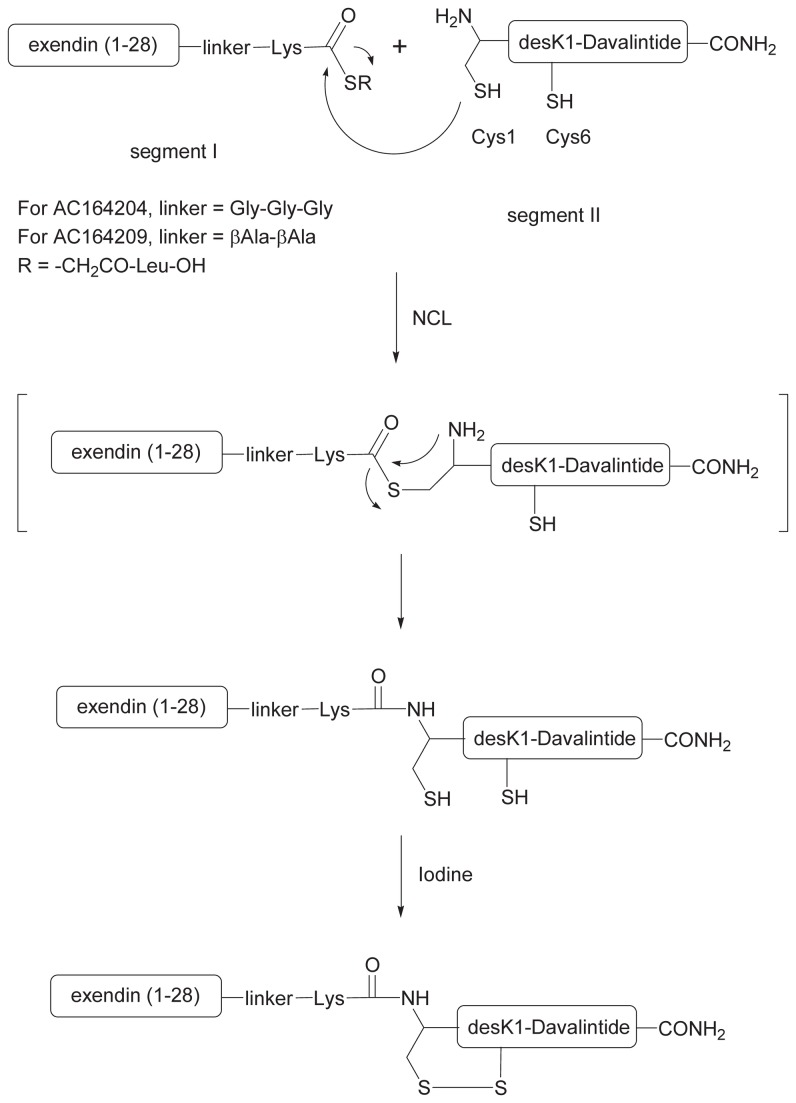
General reaction scheme for the preparation of AC164204 and AC164209.Two peptide segments I and II were used. Segment I is a thioester that contains AC3082 sequence, a linker portion and a Lysine at the C-terminus. Segment II is uncyclized desK1-Davalintide with a free cysteine at the N-terminus to provide a reactive moiety for the native chemical ligation. The linker in segment I is Gly-Gly-Gly for AC164204 and β-Ala-β-Ala for AC164209. The sequence of AC3082/exendin(1-28) is HGEGTFTSDLSKQMEEEAVRLFIEWLKN and the sequence of desK1-davalintide is CNTATCVLGRLSQELHRLQTYPRTNTGSNTY.